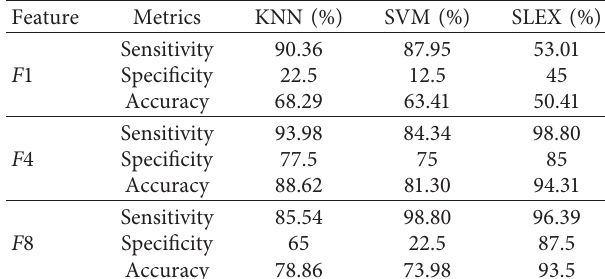
Figure 7: (a) F 3; (b) F 4; (c) F 6; (d) F 8. High lifetime (red line) and low lifetime (blue line). Table 4: Classification performance compared with KNN and